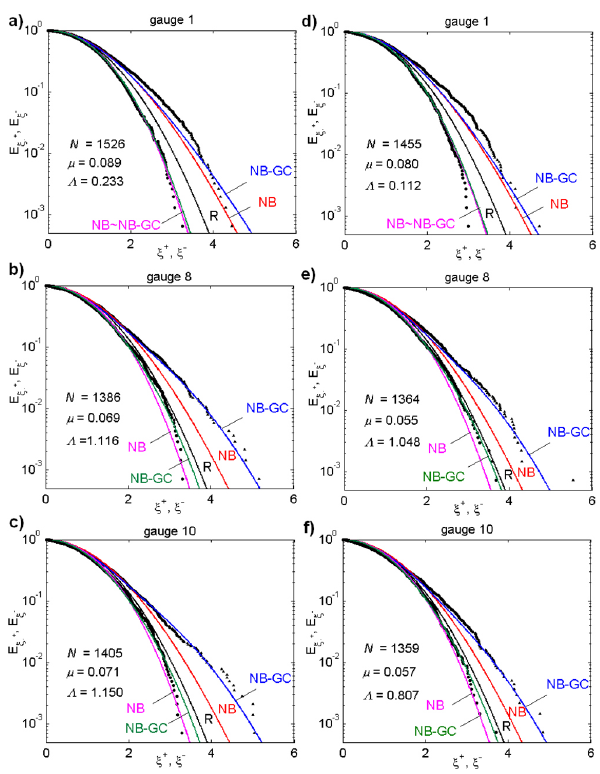
Figure 9. Exceedance distributions of wave crests and troughs along the tank for (a–c) test 8230 and (d–f) test